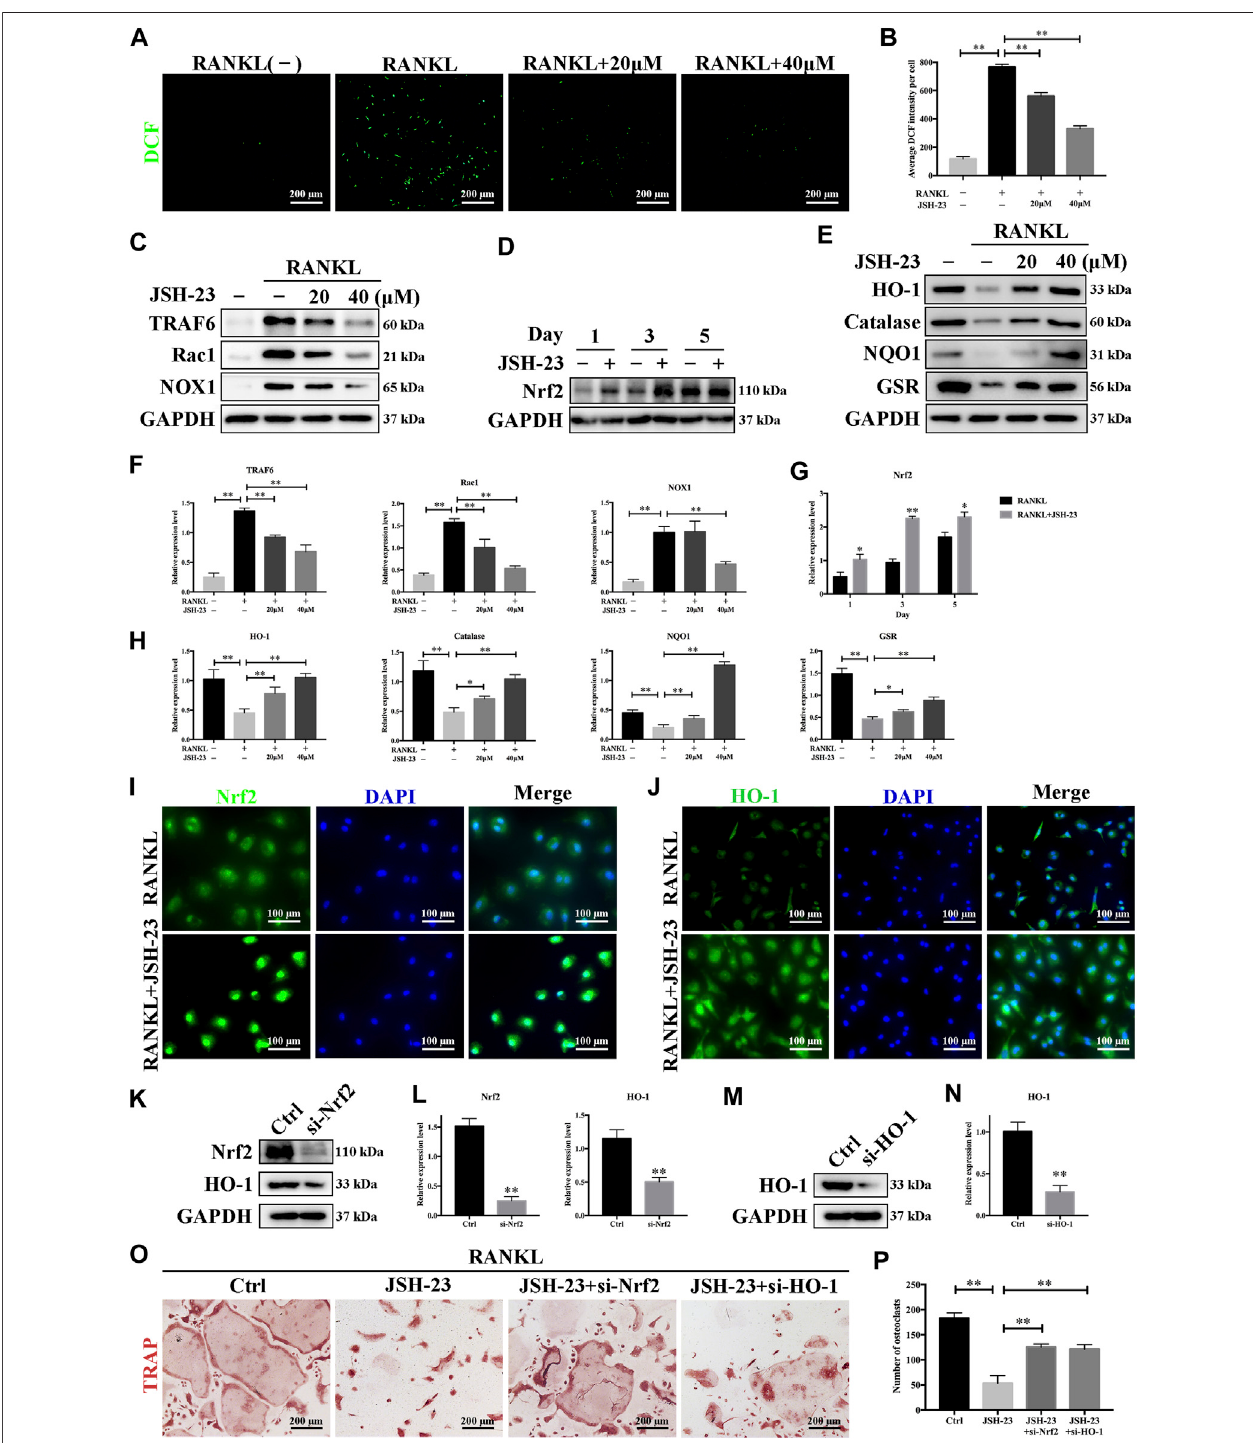
FIGURE 4 | JSH-23 reduces RANKL-induced ROS production during osteoclastogenesis by downregulating the TRAF6/Rac1/NOX1 signaling pathway and enhancing the expression of Nrf2/HO-1. (A) Representative images of RANKL-induced ROS generation in BMMs with or without JSH-23 treatment at different concentrations. (B) Quanti fi cationoftheaverageDCFintensityperwell. (C) BMMswerestimulatedwithRANKLintheabsenceorpresenceofJSH-23(20and40 μ M)for 48 h, and then the ROS production pathway wasanalyzed by western blotting. (D) BMMs were cultured in α -MEM containing M-CSF and RANKL in the presence ofJSH-23(40 μ M)attheindicatedtimes(1,3,5 days).TheexpressionofNrf2wasanalyzedbywesternblotting. (E) WesternblottingimagesoftheeffectsofJSH-23on antioxidant enzyme, HO-1, catalase, NQO1, and GSR expression. (F – H) Quantitative analysis of the western blotting results. (I) Representative immuno fl uorescence